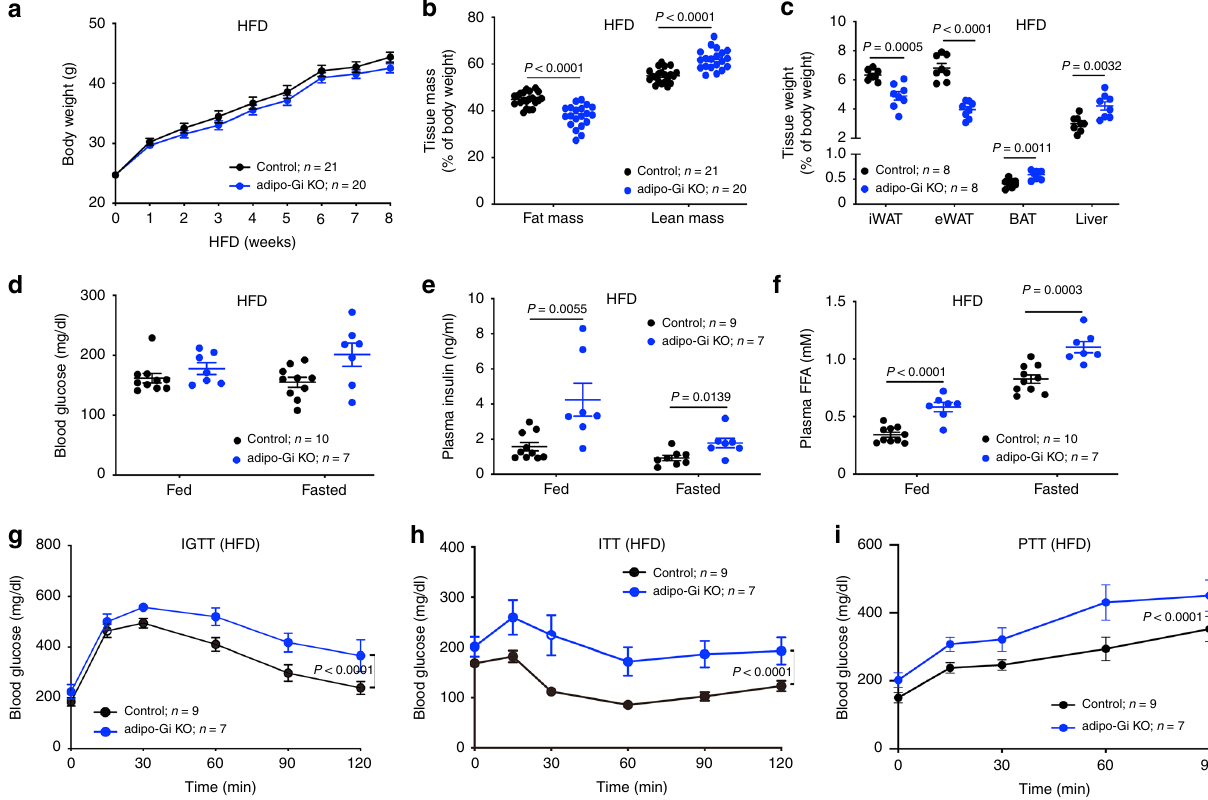
Fig. 1 Mice lacking G i signaling in adipocytes show metabolic impairments when maintained on a HFD. a Body weight growth curves of control and adipo-Gi KO mice (males) maintained on a HFD. b Fat and lean body mass of control and adipo-Gi KO mice maintained on HFD for 8 weeks. c Weight of inguinal white adipose tissue (iWAT), epididymal white adipose tissue (eWAT), brown adipose tissue (BAT), and liver of control and adipo-Gi KO mice fed with HFD for 8 weeks. d – f Freely fed and fasting blood glucose ( d ), plasma insulin ( e ), and plasma free fatty acid (FFA) levels ( f ) of control and adipo-Gi KO mice maintained on HFD for 8 weeks. g – i In vivo metabolic tests carried out with control and adipo-Gi KO mice maintained on HFD for 8 weeks. g I.p. glucose tolerance test (1 g/kg glucose; IGTT). h Insulin tolerance test (1 U/kg insulin, i.p.; ITT). i Pyruvate tolerance test (2 g/kg pyruvate, i.p.; PTT). Data are given as means ± s.e.m. P values are indicated in the different panels ( a , g – i : two-way ANOVA followed by Bonferroni ’ s post hoc test; b – f : two-tailed Student ’ s t test). Source data are provided as a Source data fi whole-body glucose homeostasis, we subjected both RC and HFD adipo-Gi KO mice and their control littermates to i.p. glucose, insulin, and pyruvate tolerance tests (IGTT, ITT, and PTT, respectively). RC mutant and control mice displayed similar glucose tolerance and insulin sensitivity (IGTT and ITT, respec- tively) (Supplementary Fig. 2f, g). In contrast, HFD adipo-Gi KO mice showed signi fi cantly impaired glucose tolerance and insulin sensitivity, as compared to their HFD control littermates (Fig. 1g, h). Moreover, the HFD KO mice displayed markedly enhanced blood glucose excursions in the PTT, consistent with increased hepatic glucose production (Fig. 1i). Taken together, these data indicate that lack of adipocyte G i signaling caused impaired glucose homeostasis and insulin sensitivity when mice were metabolically challenged by an obesogenic, calorie-rich diet.